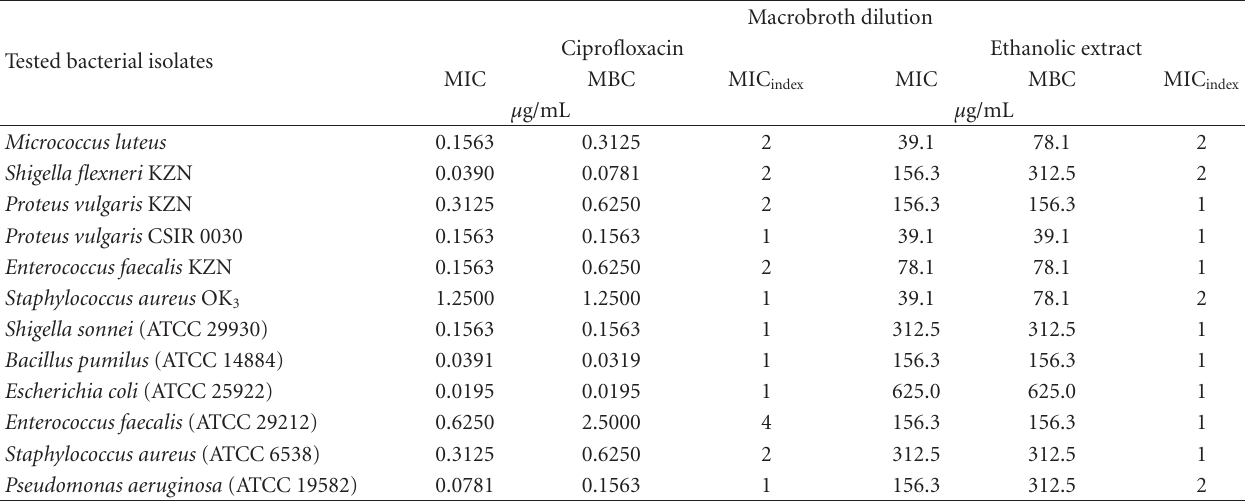
Table 2: Antibacterial activity of the ethanolic extract of Erythrina ca ff ra Thunb.